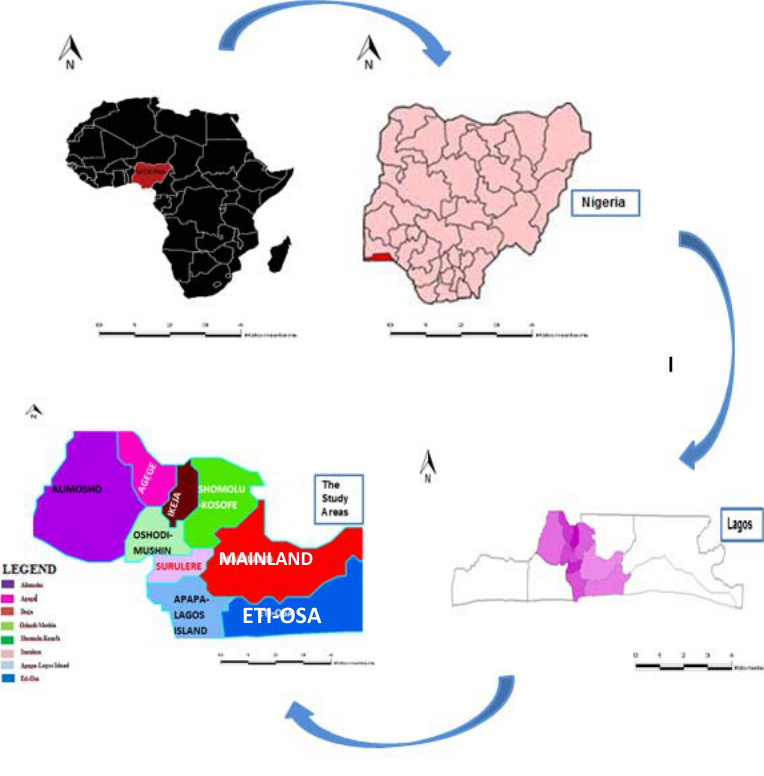
Fig. 1: The study Fig. 1: The study area